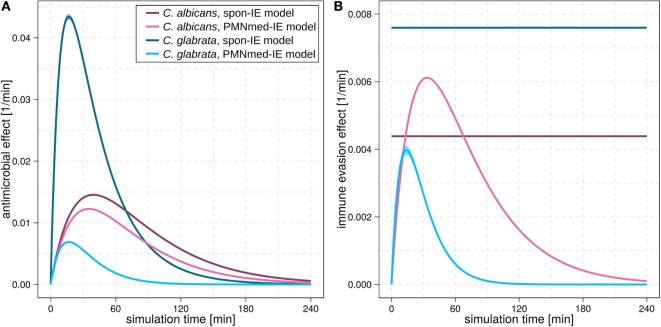
Kinetics of the extracellular killing rate (A) and immune-evasion rate (B) predicted by spon-IE model and PMNmed-IE model. In both subfigures, purple lines represent results of infection with Candida albicans and blue lines depict results of infection with Candida glabrata. Predictions by the spon-IE model and PMNmed-IE model are indicated by dark colored lines and pale colored lines, respectively.